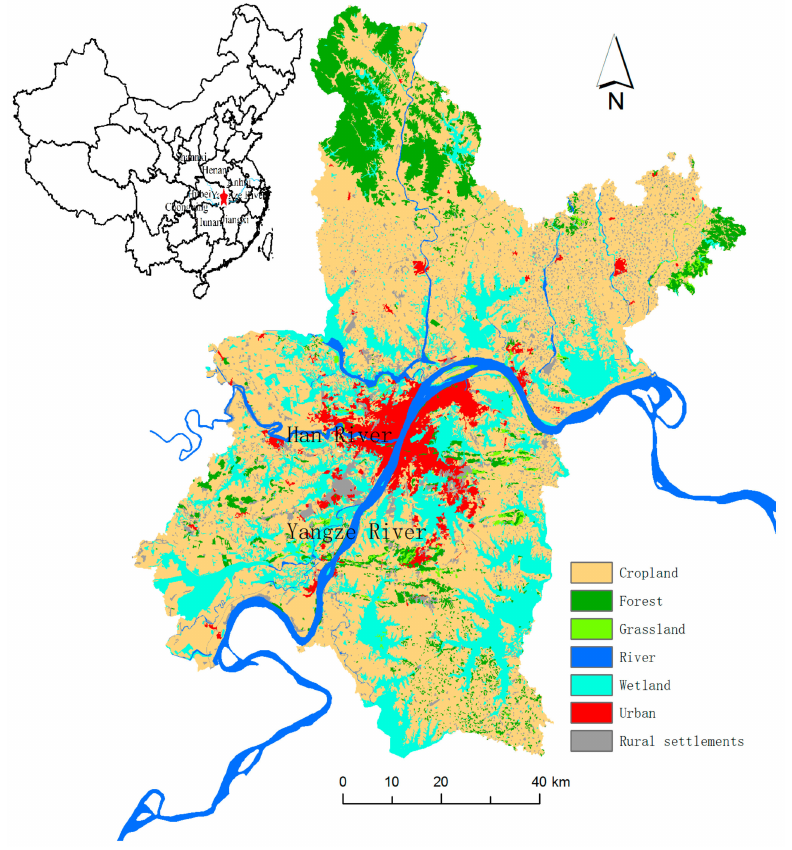
Figure 1. Land use in the study area in 2010, and its location in